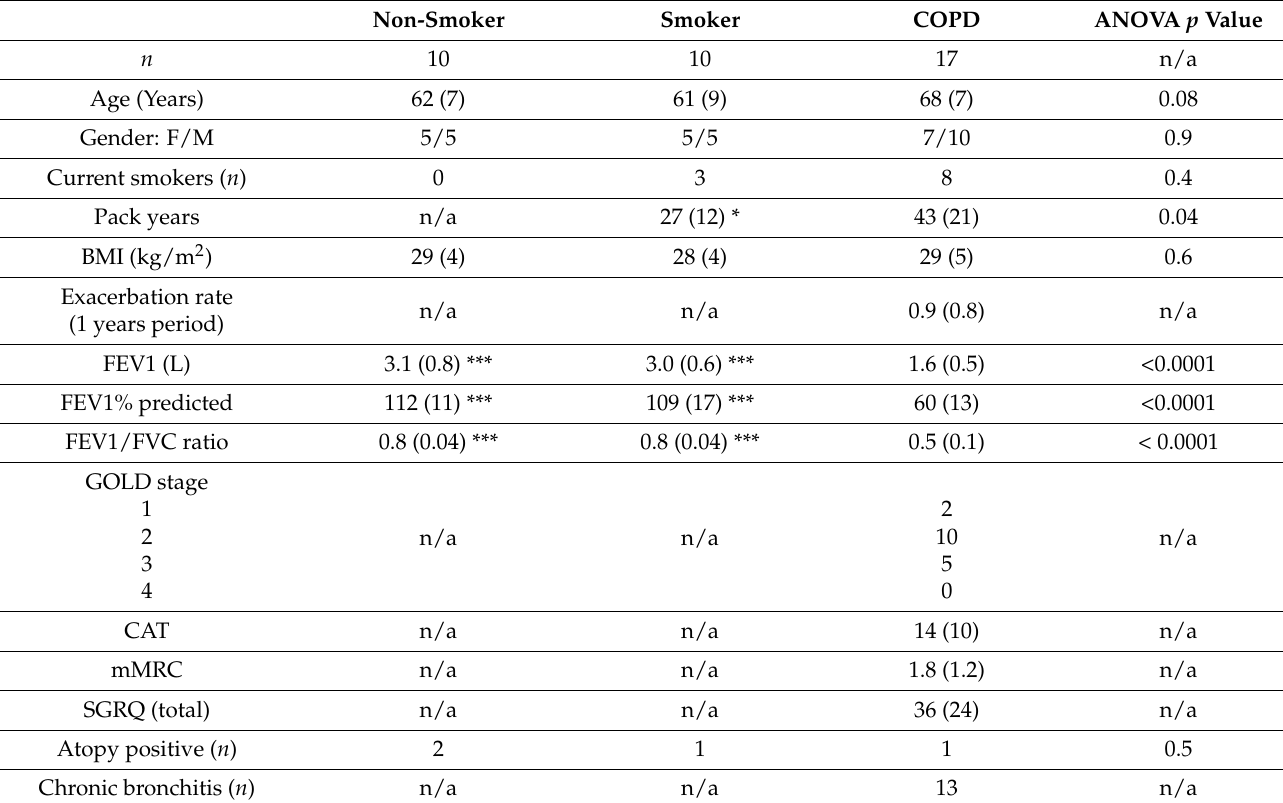
Table 1. Clinical characteristics of the sputum study